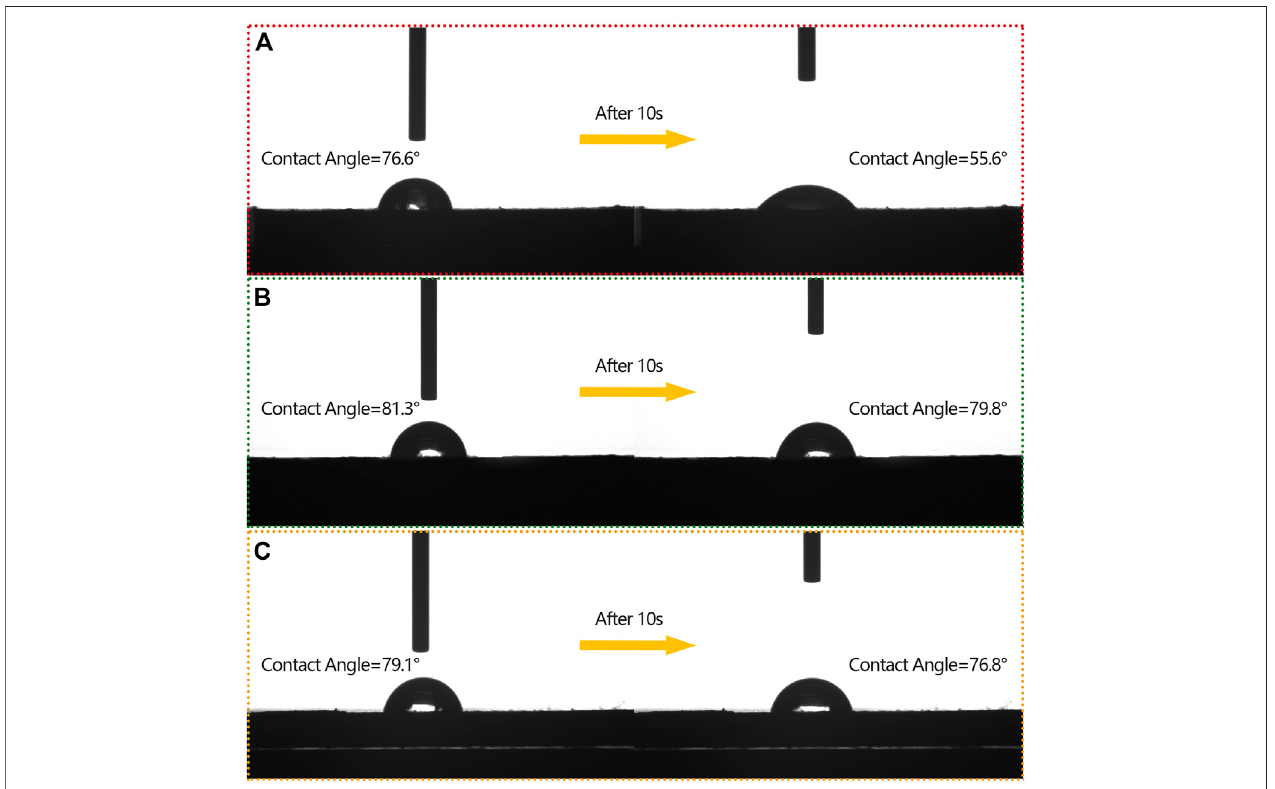
FIGURE5| TheimageofwatercontactangletestonNWandCWsurface. (A) ImageofthewatercontactangleofNWattheinitialtimeand10 slater. (B) Imageof the water contact angle of CW at the initial time and 10 s later. (C) Image of the water contact angle of CW immersed in water.